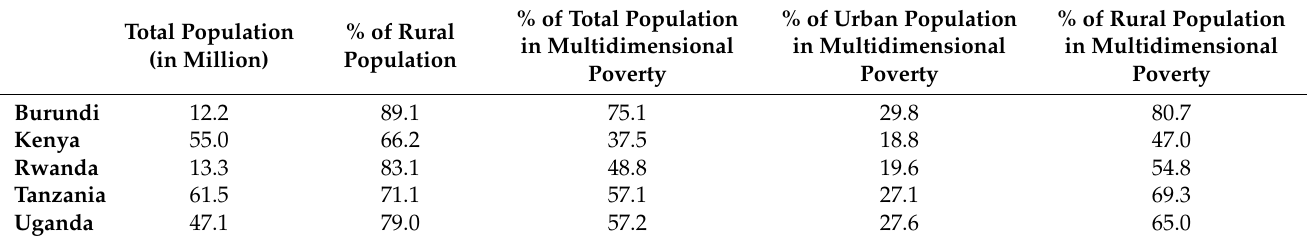
Table 1. Population and poverty rates in countries of the East African